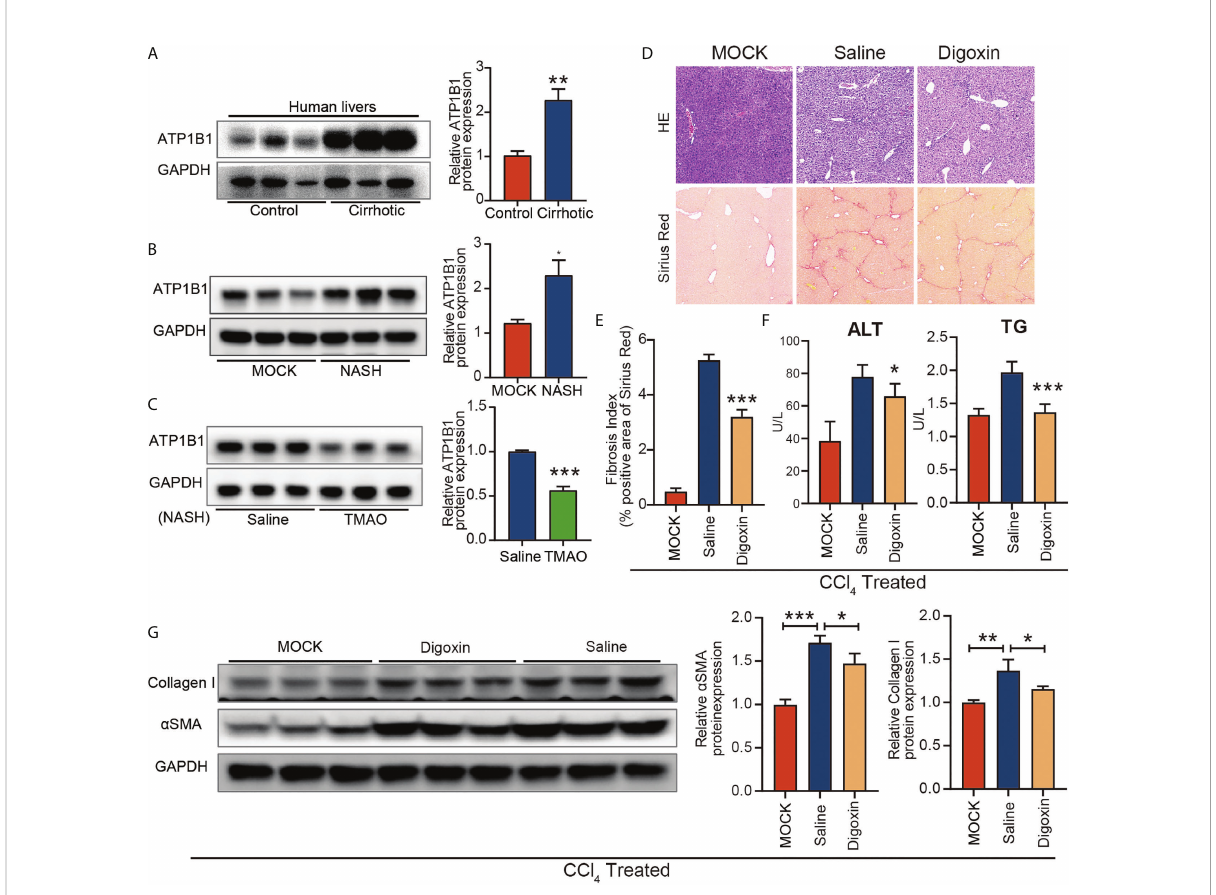
FIGURE 6 Blockage of ATP1B1 attenuates liver fi brosis (A – C) Immunoblots of ATP1B1 relative to GAPDH protein from NASH con fi rmed human and mouse samples (A – B) . Immunoblot analysis of ATP1B1 protein in NASH-TMAO mice (C) (D – E) Digoxin reduces liver fi brosis by histological analysis of Sirius Red-stained sections. (F) Digoxin prevents hepatocellular damage as measured by the serum levels of ALT and TG. (G) Western blot of Collagen 1 and a SMA. *p<0.05, **p<0.01,